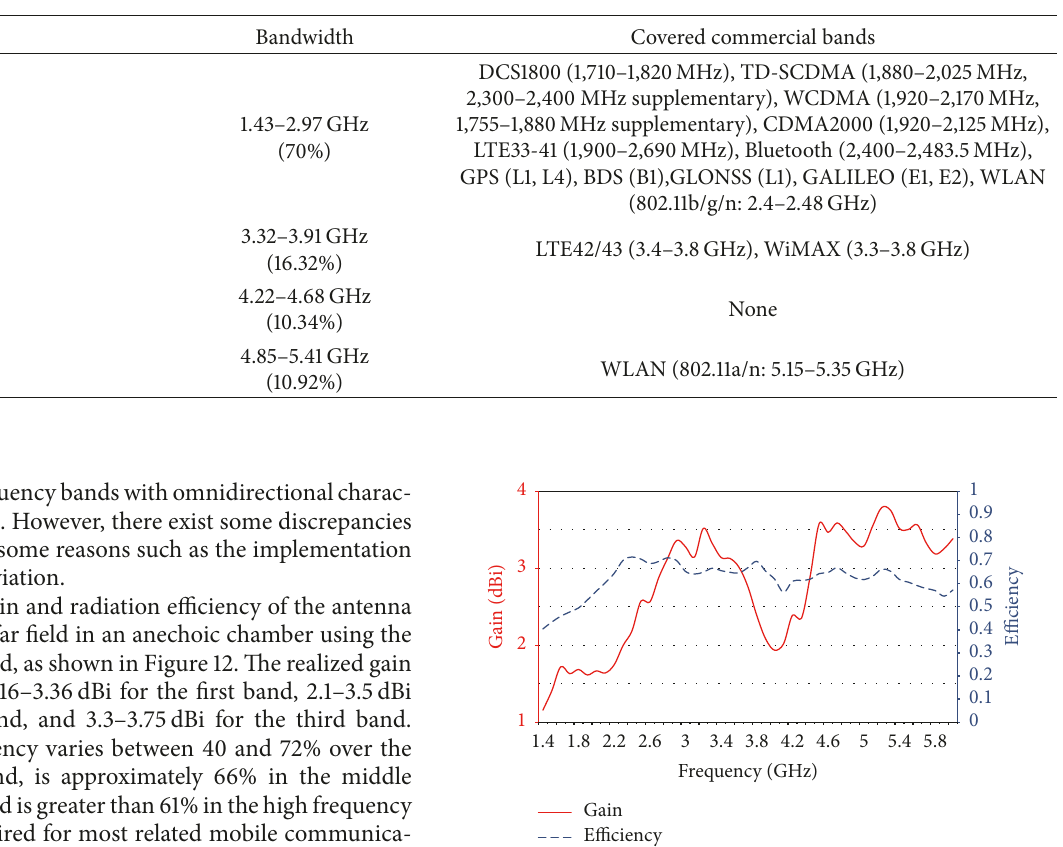
Table 3: Measured bandwidth and frequency bands covered by the antenna.